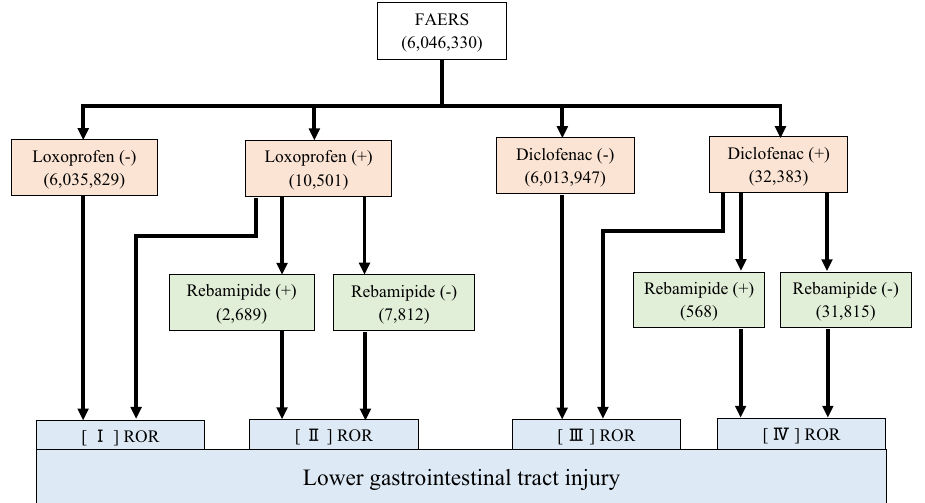
Figure 1. Flow chart summarizing the determination of RORs for lower gastrointestinal tract injury categorized according to drug usage in FAERS. Numbers in parentheses indicate the number of adverse drug reactions reported. [I] ROR shows the odds ratio of lower gastrointestinal tract injury for loxoprofen alone and for drugs excluding loxoprofen. [II] ROR shows the odds ratios for loxoprofen with and without rebamipide. [III] ROR shows the odds ratio of lower gastrointestinal tract injury for diclofenac alone and for drugs excluding diclofenac. [IV] ROR shows the odds ratios for diclofenac with and without rebamipide.